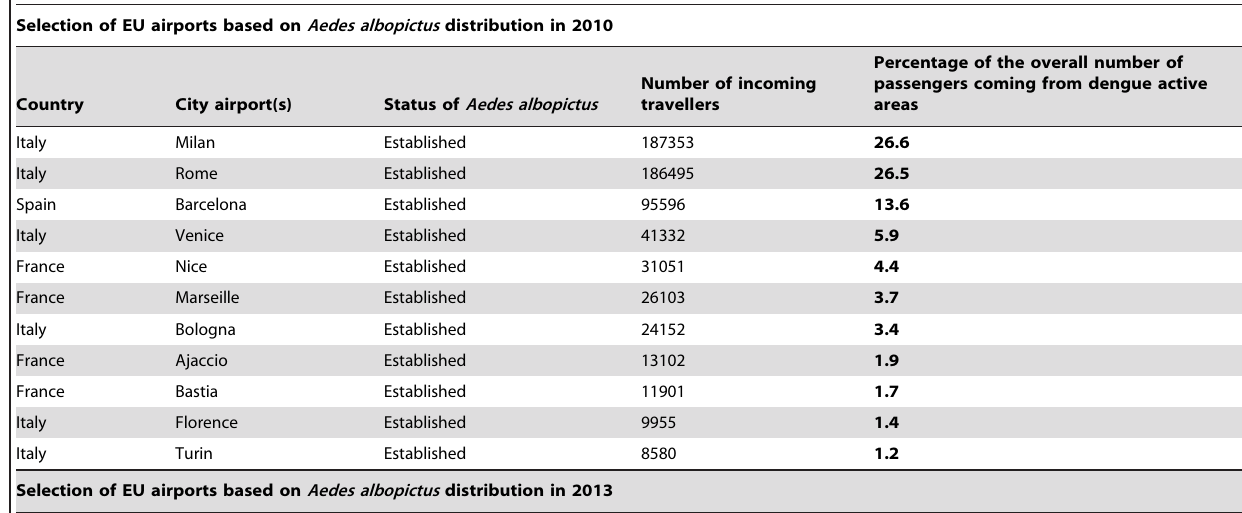
Table 1. Distribution of travellers from dengue affected areas (endemic and epidemic) coming into airports in the parts of Europe in 2010 where Ae. albopictus has been recorded in 2010 and 2013.